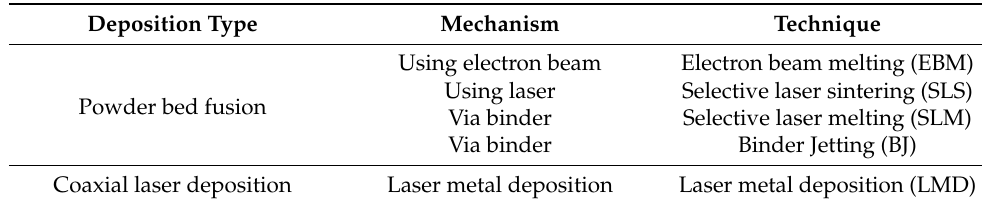
Table 6. Classification of AM methods (from different types of feedstocks: metals, ceramics, polymers) [144].